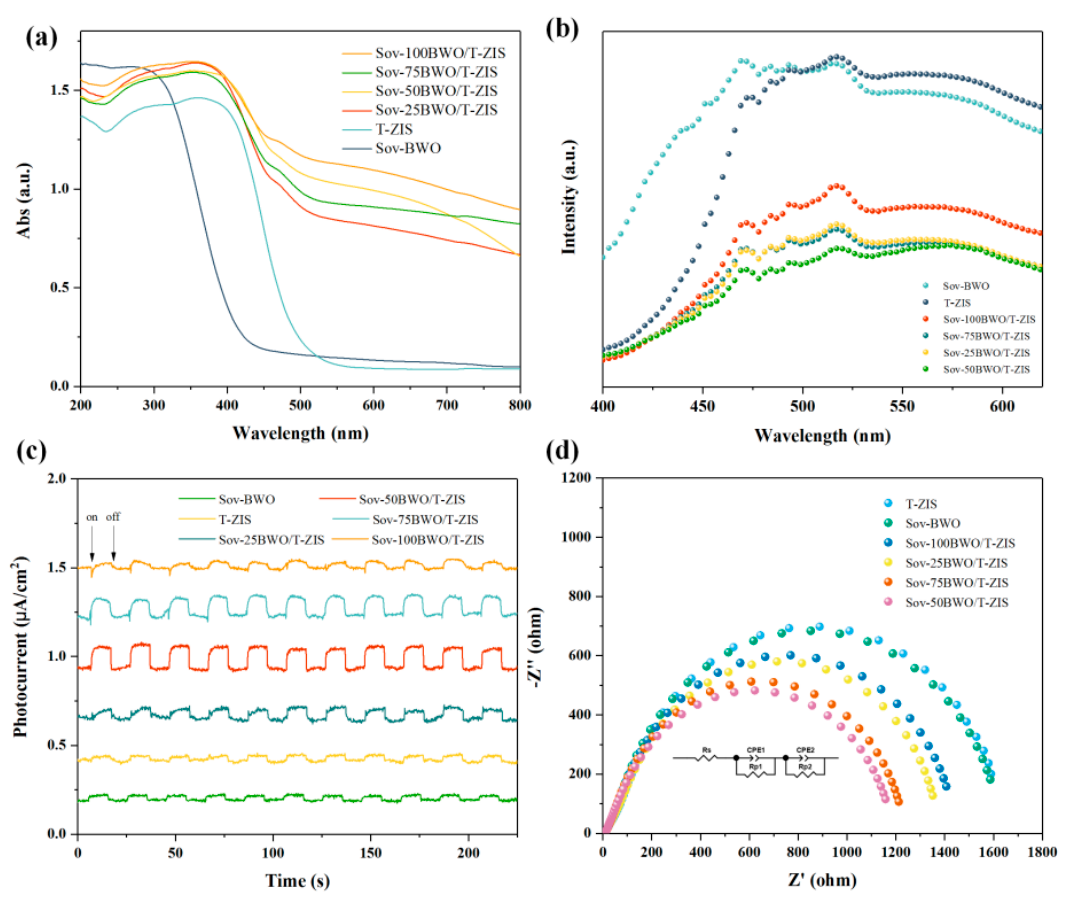
Figure 5. ( a ) UV-vis diffuse reflectance spectra. ( b ) Photoluminescence spectra. ( c ) Transient photocurrent curves. ( d ) Nyquist plots (EIS).